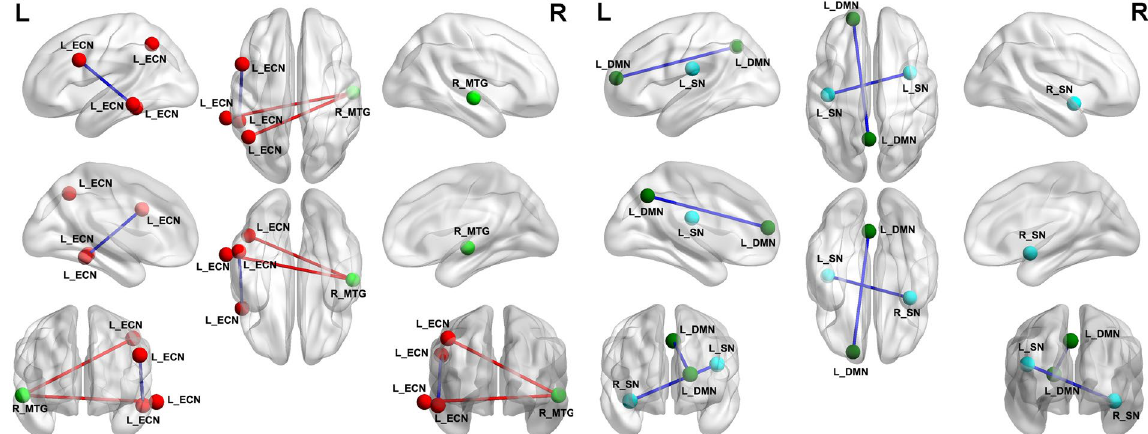
Figure 6. A holistic view of seed-based functional connectivity differences in intra- and inter-network between PIs and GSs. Note: Seed-based functional connectivity differences were found within the ECN, DMN and SN, and between the MTG and the ECN. Abbreviations: R, right; L, left; ECN, Executive control network; SN, Salience network; DMN, Default mode network; MTG, Middle temporal gyrus; PIs, Patients with primary insomnia; GSs, Good